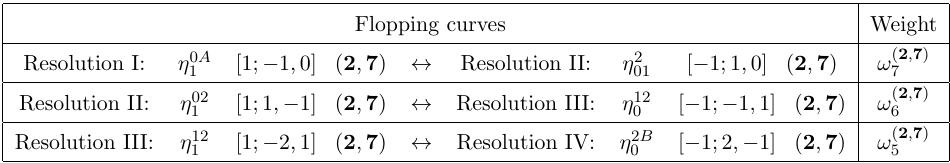
Table 4 . Flopping curves between di(cid:11)erent crepant resolutions of the SU(2) (cid:2) G